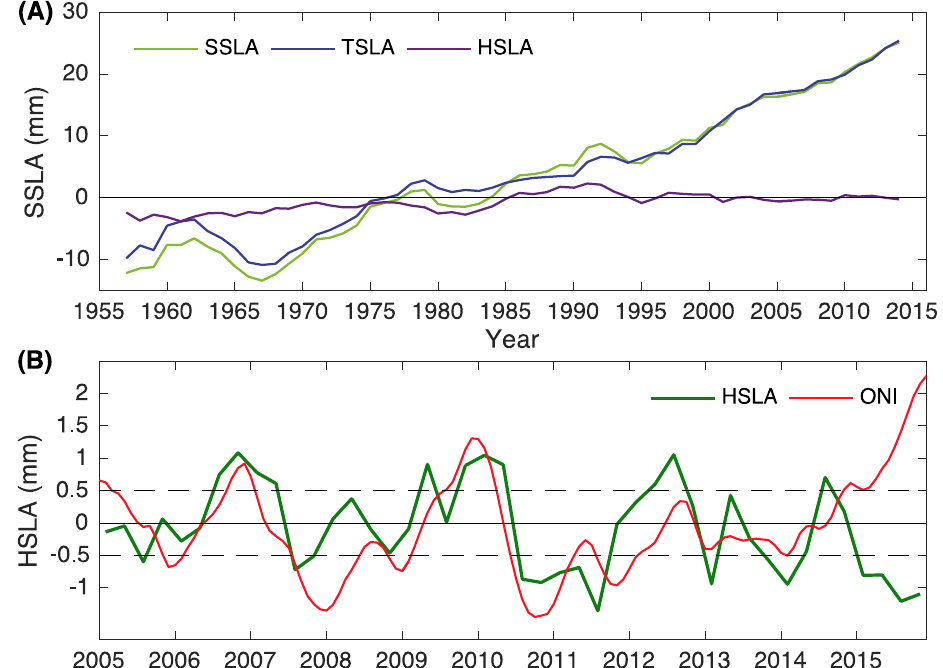
Figure 2. ( A ) SSLA, TSLA, and HSLA, calculated from the NCEI dataset, since 1955; ( B ) The global HSLA time series (ensemble mean of multi-datasets), compared with the Oceanic Niño Index (ONI), since 2005. ONI is available at https://www.esrl.noaa.gov/psd/data/climateindices/list/. 12-month running mean is used to remove the annual cycle.